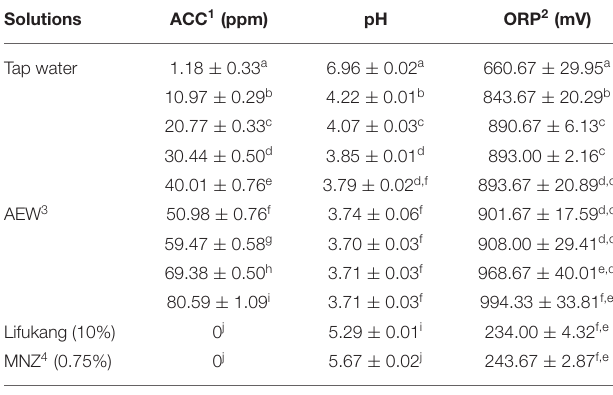
TABLE 1 | Properties of AEW with different ppm, Lifukang, and MNZ.